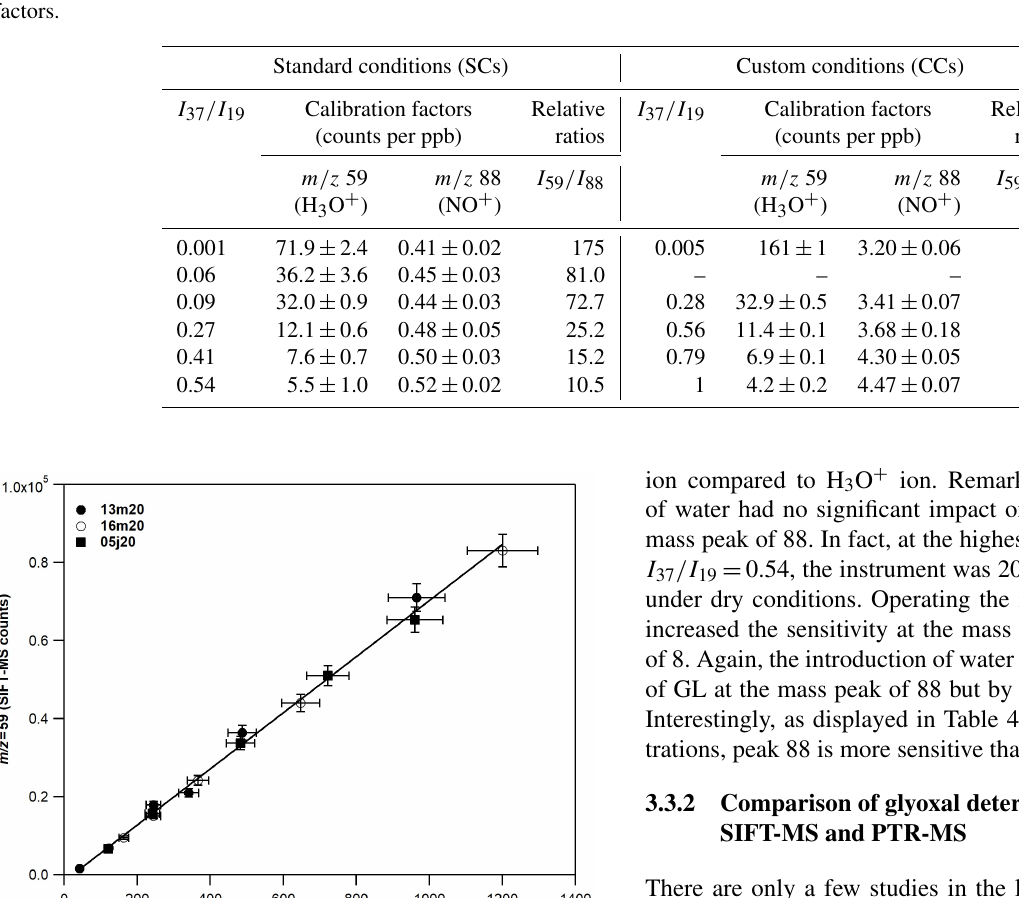
(cid:113) NO + ), ) and m/z 88 (C 2 H 2 O 2 2